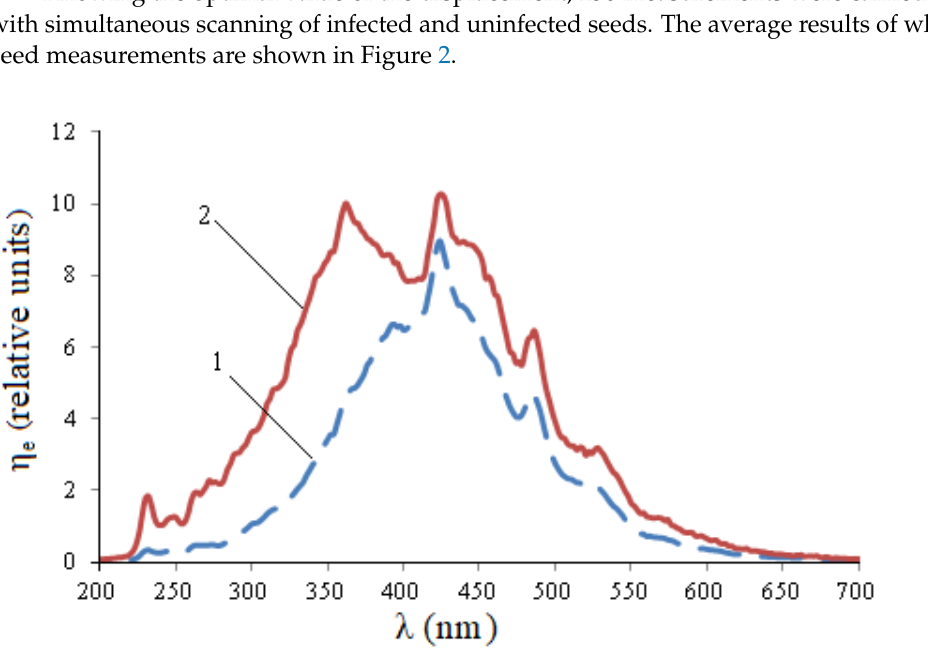
Figure 2. Spectral characteristics of excitation of wheat seeds during synchronous scanning: 1 — not infected, 2 — 98% infected.